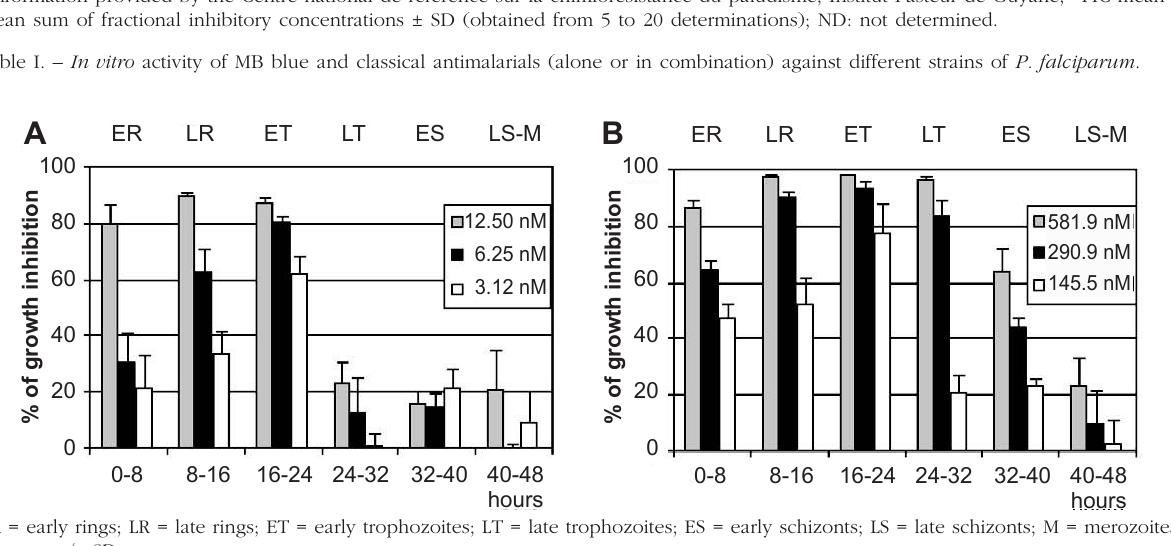
Fig. 1. – Sensitivity of the different stages of P. falciparum FcB1 strain to increasing doses of methylene blue and quinine: (A) methylene blue; (B)